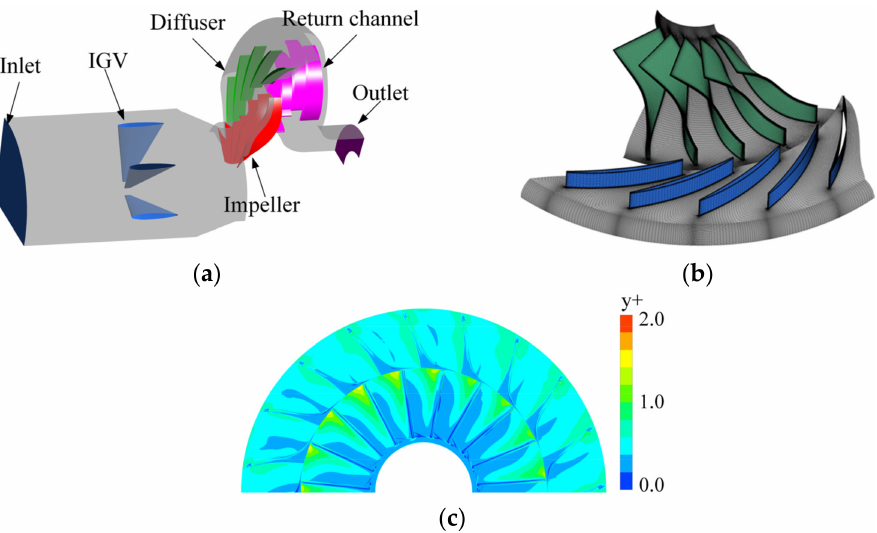
Figure 2. Schematic diagram of the computational domain and computational grid: ( a ) all computa- tional domain; ( b ) computational grid; ( c ) y